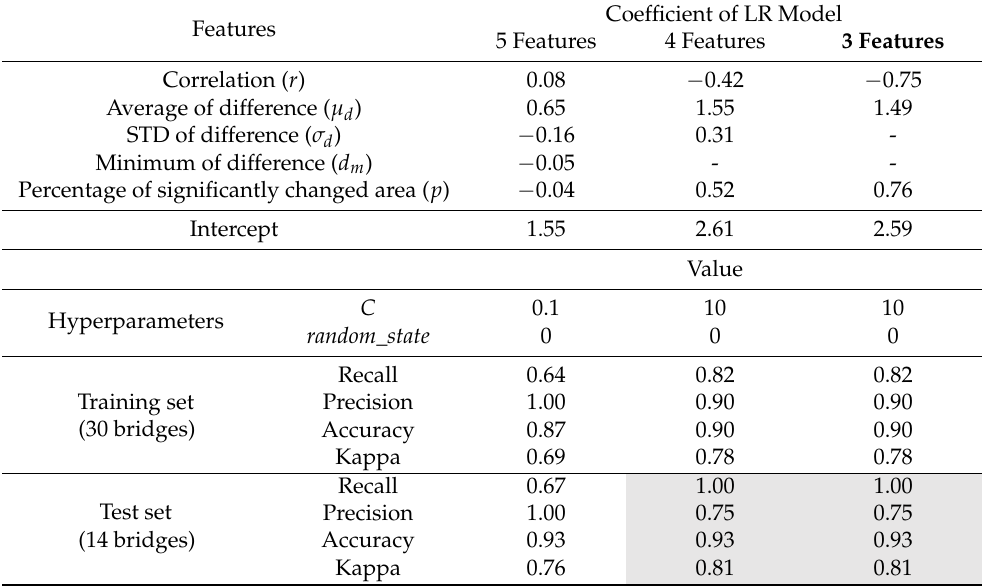
Table 6. Comparison of the LR models using data set 1 with different numbers of features, where the best model is emphasized in bold font. The highest accuracy for the test set is emphasized by the gray